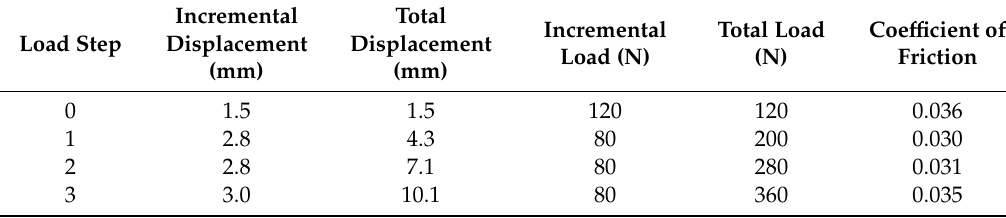
Table 2. Measured displacement, axial load, and coefficient of friction from modelling.